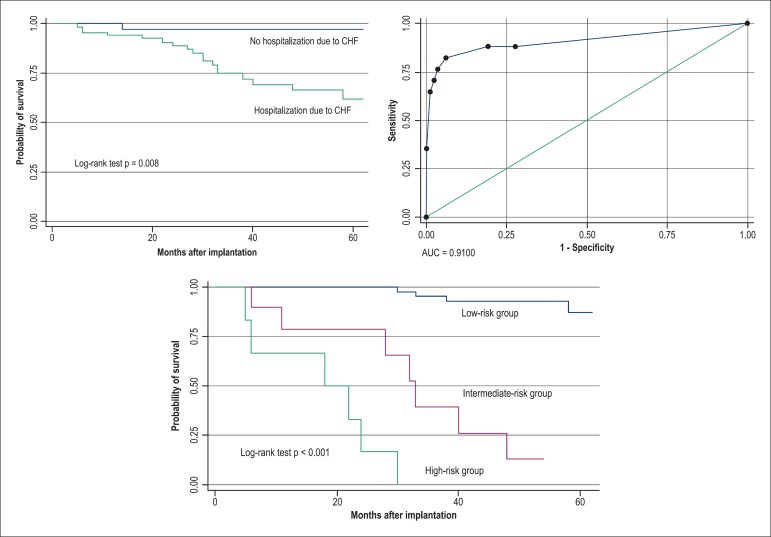
Kaplan-Meier curve of the variable hospitalization due to congestive heart
failure (CHF), which, associated with right ventricular dysfunction and use of
high doses of diuretics, formed the predictive model of cardiac death/Tx at
time 2 (1st year). The absence of the three variables or the
presence of only one (low risk) indicates an event‑free rate in 30 months of
98%. At the top right, the ROC curve with an area under the curve (AUC) of
0.91, sensitivity of 76.4%, specificity of 96.3%, and accuracy of 93%.